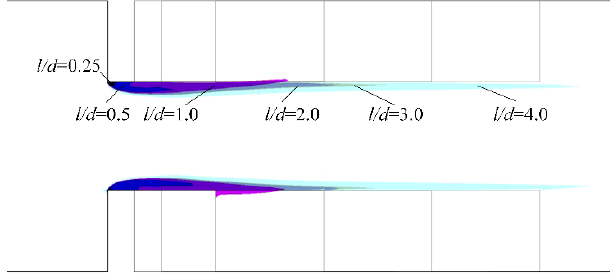
Figure 11. Vapor volume fraction on the symmetry plane vs. different l/d when the pressure difference is 300 kPa.